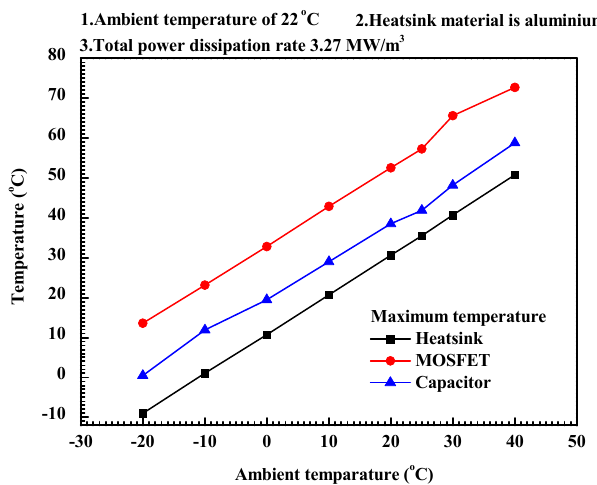
Figure 11. Variation of the temperatures of the ECU heatsink, MOSFET and the capacitor of the 36V ECU system with the ambient temperature.